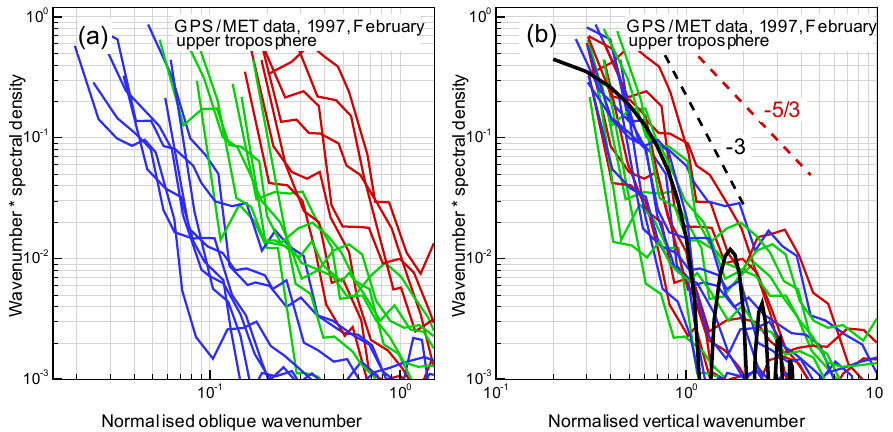
Figure 5. The normalized eikonal fluctuation spectra for the upper troposphere. (a) Spectra as functions of the oblique wave number corre- sponding to the isotropy hypothesis; (b) spectra as functions of the vertical wave number corresponding to the anisotropy hypothesis. The notations are the same as in Fig.